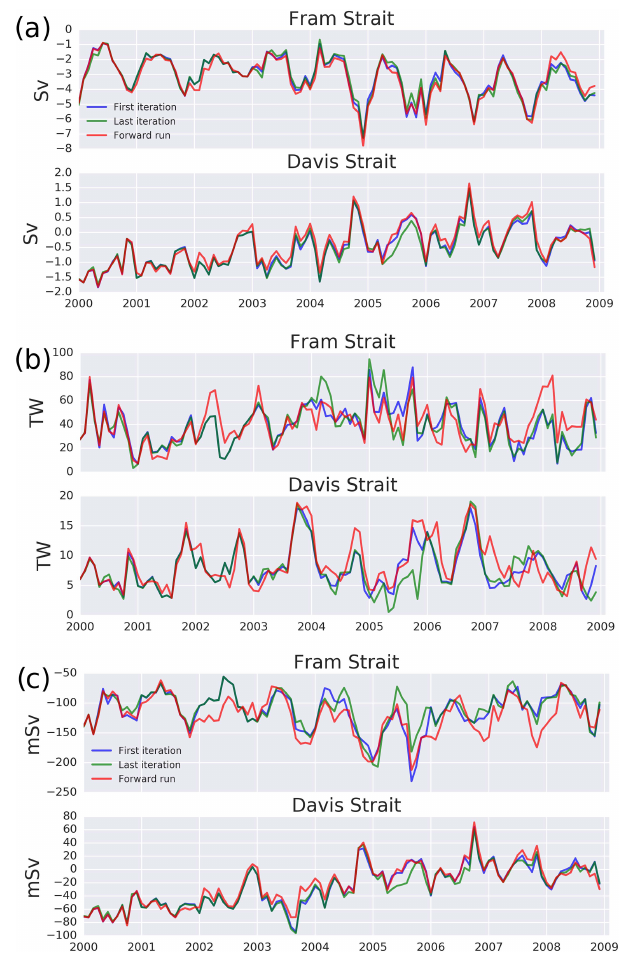
Figure 11. Fluxes through the Fram and Davis straits of (a) vol- ume, (b) heat and (c) freshwater. Positive fluxes are into the Arctic Ocean. Results are shown for the forward run (red), for the run be- fore assimilation (blue) and for the run after assimilation